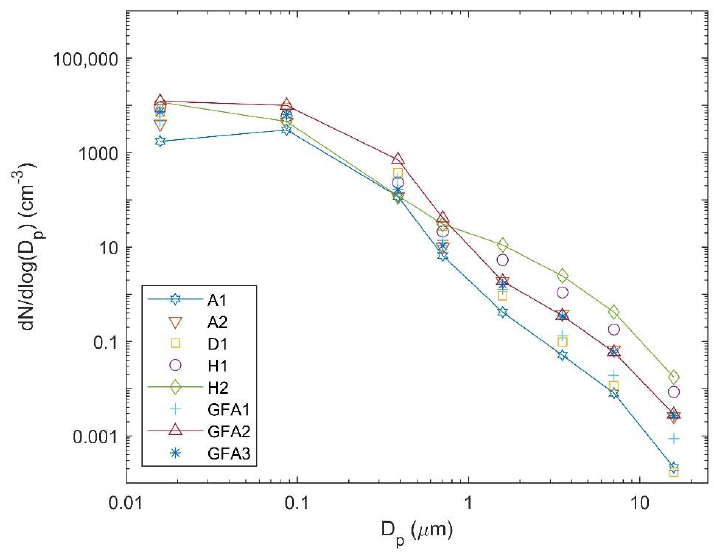
Figure 2. Mean indoor particle number size distributions during background periods for each home. The legend refers to the home ID.